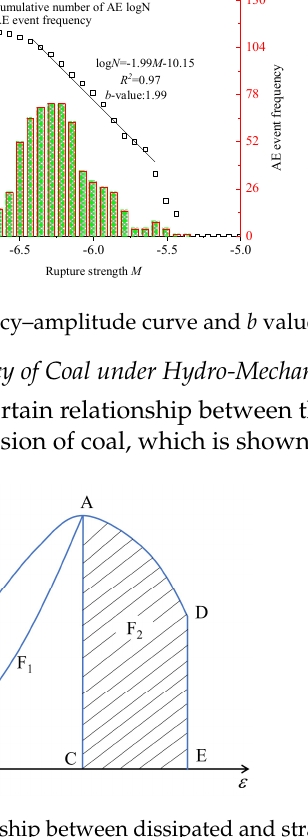
Figure 17. Relationship between dissipated and strain energies on stress–strain curve during uniaxial compression of coal. O, A and D correspond to the starting, peak stress and post peak value of the stress-strain curve respectively. B is the strain value of the model after unloading. C and D are the strain values corresponding to the peak and post peak stresses, respectively. A schematic of the energy burst tendency is shown in Figure 17, where F1 represents the difference between the elastic energy accumulated before the peak and the dissipated energy consumed during the plastic deformation and crack development of the coal. F2 represents the energy consumed when the coal is damaged after the peak, i.e., F1/F2 is an energy burst tendency indicator of the coal. In the energy module part of the PFC3D 5.0 software (Itasca Consulting Group, Inc., Minneapolis, MN, USA), the total strain energy includes the strain energy ( E ) and the bond strain energy ( E ), and the total dissipated c pb energy includes the frictional energy ( E ) and the kinetic energy ( E ). Among them, the k slip energy remains equal to zero until the bond breaks. It can be seen that the particle flow can monitor the change in the energy in the deformation and failure process of the model in real time. Therefore, in the full stress–strain curve, the elastic and dissipation energies at any time can be expressed in PFC3D as